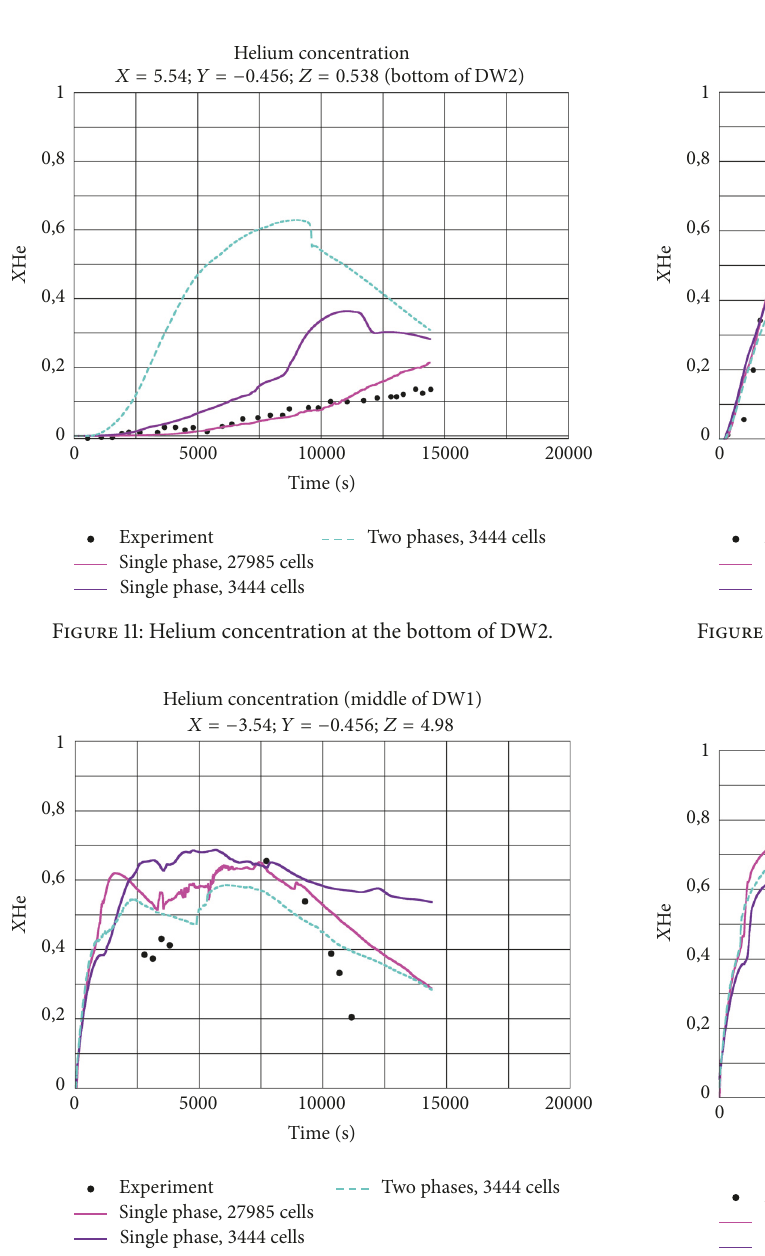
Figure 14: Helium concentration at the top of